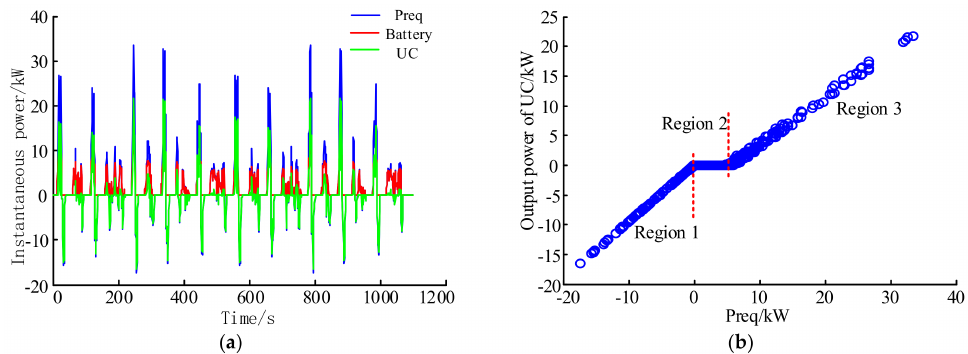
Figure 7. MANHATTAN driving cycle. UC: ultra-capacitor; Preq: power requirement of the motor. ( a ) Instantaneous power allocation; ( b ) Power relationship.